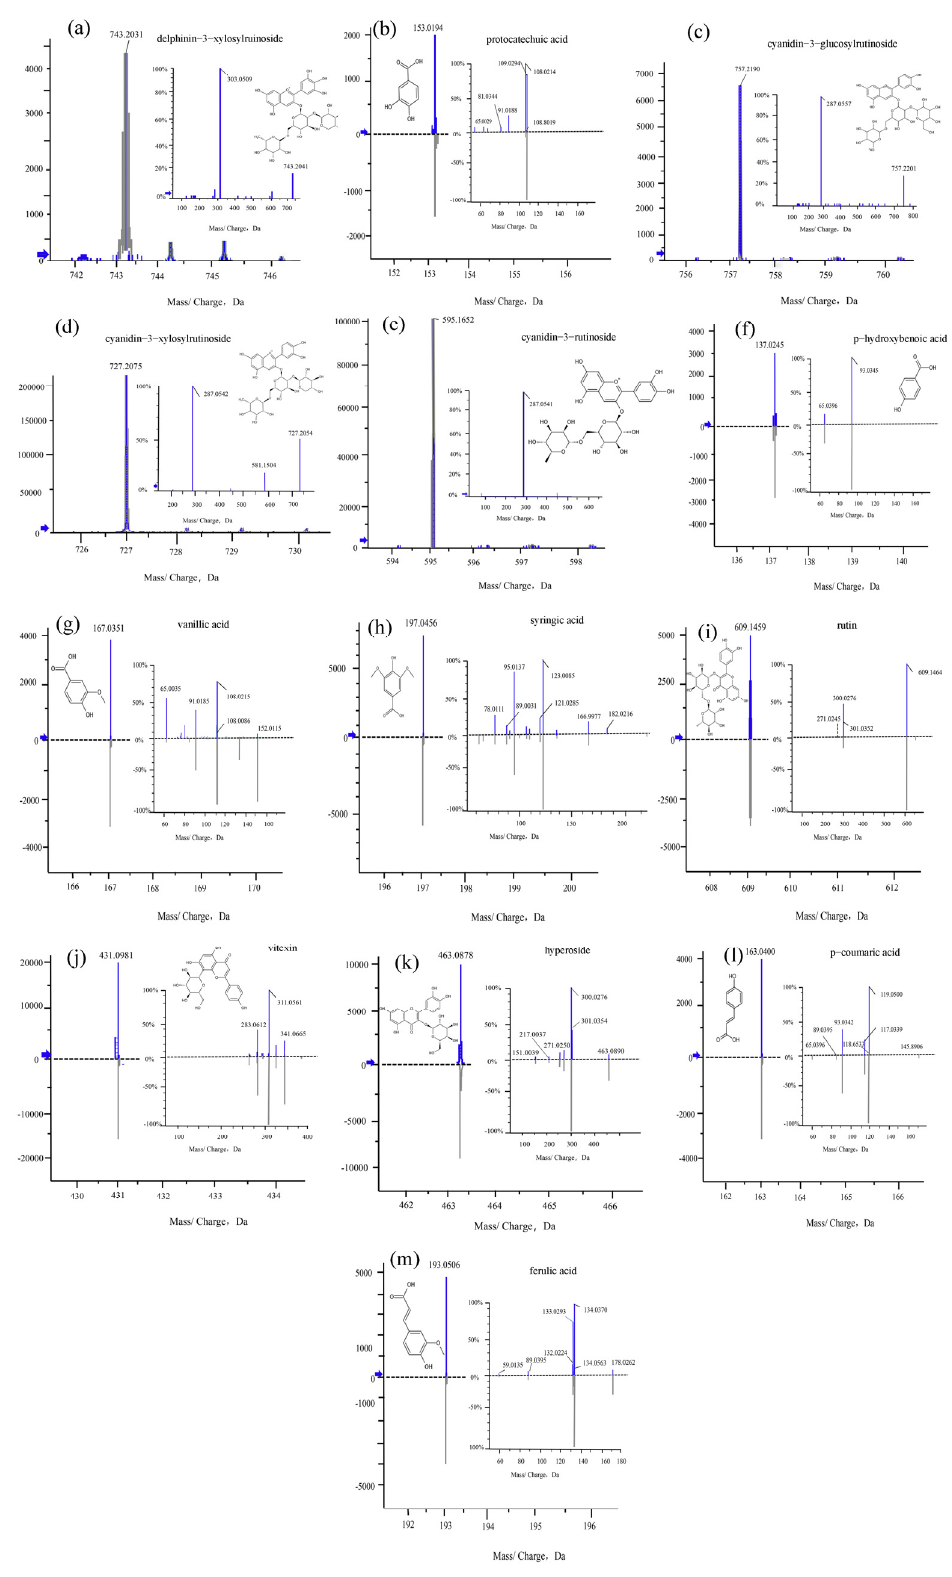
Figure 4. QTOF-MS/MS mass spectra of fragment ion and chemical structures of delphinin- 3-xylosylrutinoside ( a ); protocatechuic acid ( b ); cyanidin-3-glucosylrutinoside ( c ); cyanidin-3- xylosylrutinoside ( d ); cyanidin-3-rutinoside ( e ); p-hydroxybenzoic acid ( f ); vanillic acid ( g ); syringic acid ( h ); rutin ( i ); vitexin ( j ); hyperoside ( k ); p-coumaric acid ( l ); ferulic acid ( m